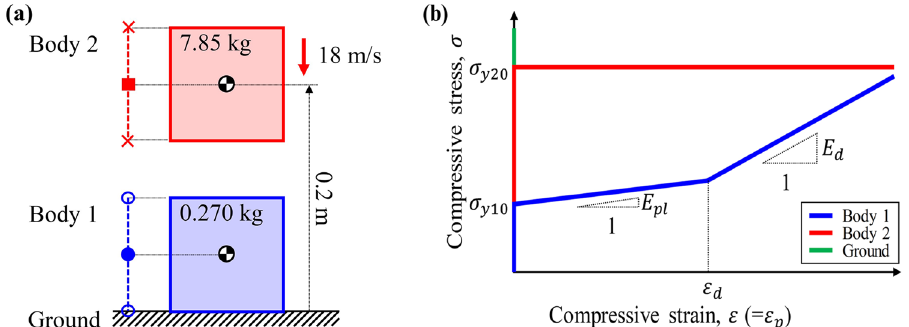
Fig. 8 a Initial condition; b Stress–strain